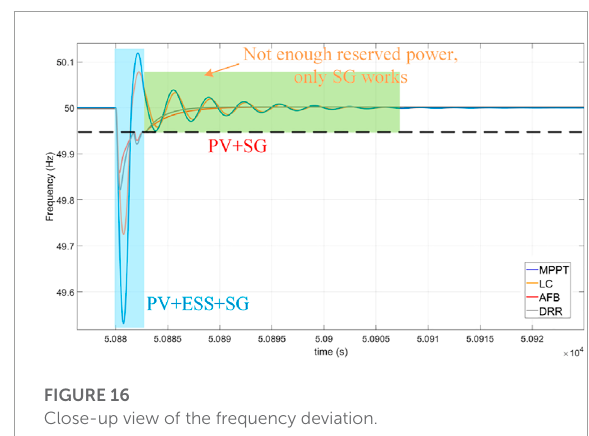
FIGURE 16 Close-up view of the frequency deviation.